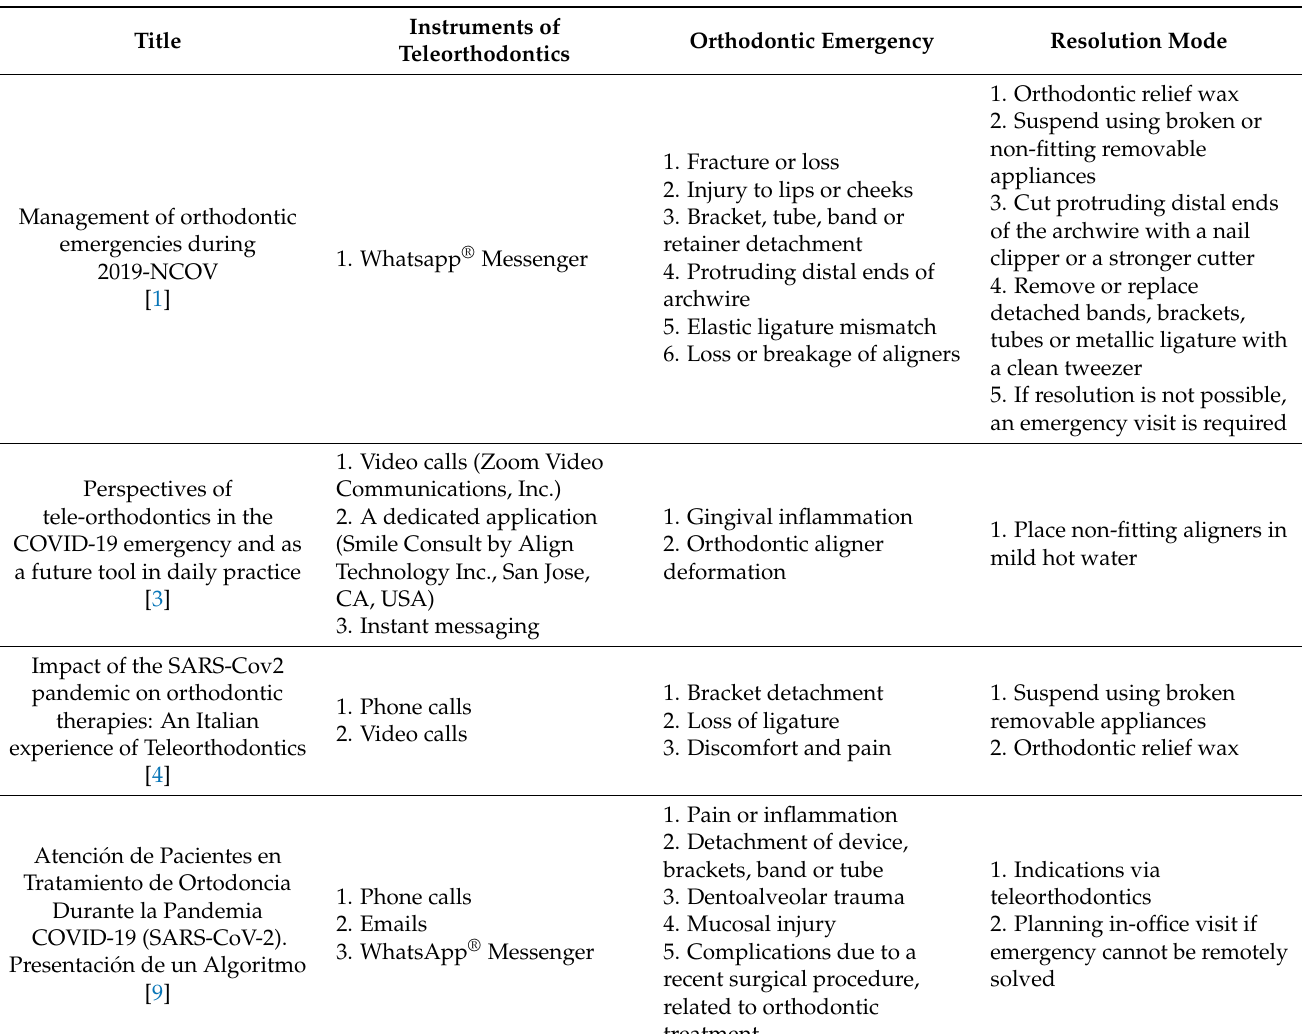
Table 2. Instruments of teleorthodontics and resolution